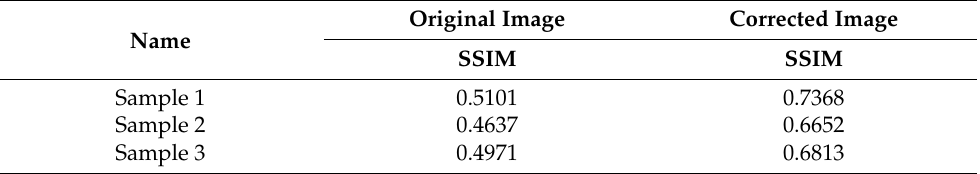
Table 1. Quantitative results for original images and corrected